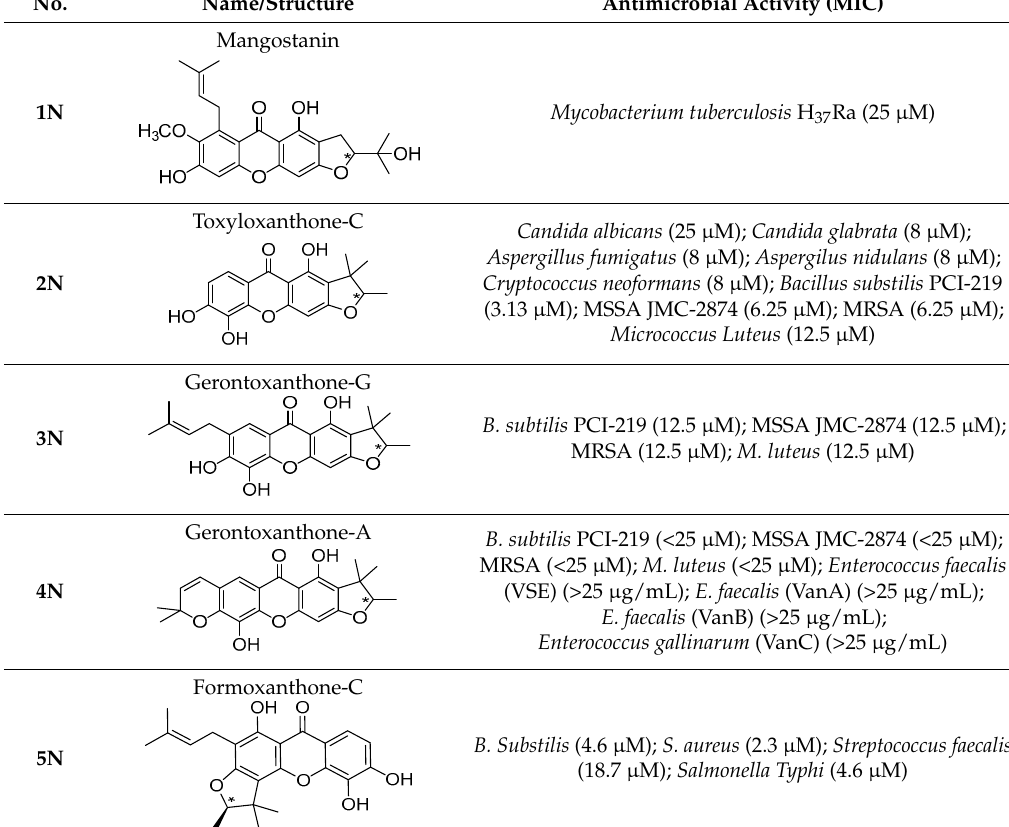
Table 2. Antimicrobial activity of natural CDXs with pyran groups.